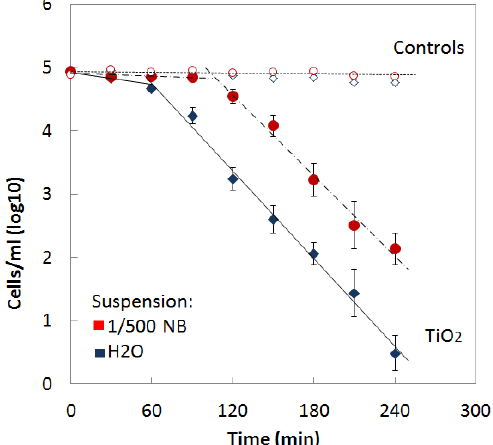
Figure 4. Survival of E. coli cells vs. irradiation time at ~5 W/m 2 with the standard error of three experiments. Mean ± SE, n =